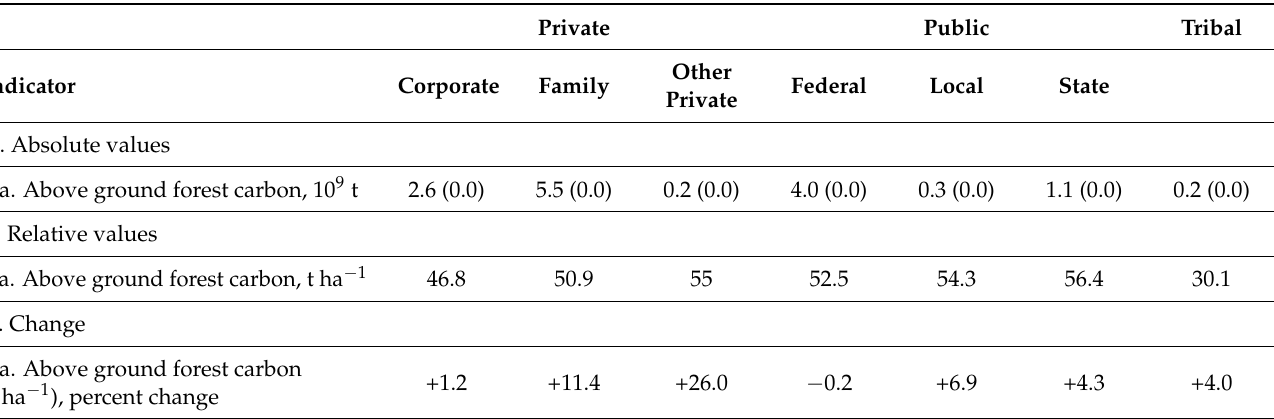
Table 6. Summary of selected Montr é al Process Criterion 5 Indicators by ownership category, conterminous USA in terms of: (A) absolute values (2019), (B) relative values (2019), and (C) change (2012–2019). Indicators, including data sources, are described in Table 1. Where available, standard errors are listed parenthetically following the estimates. Private Public Tribal Other Indicator Corporate Family Federal Local Private